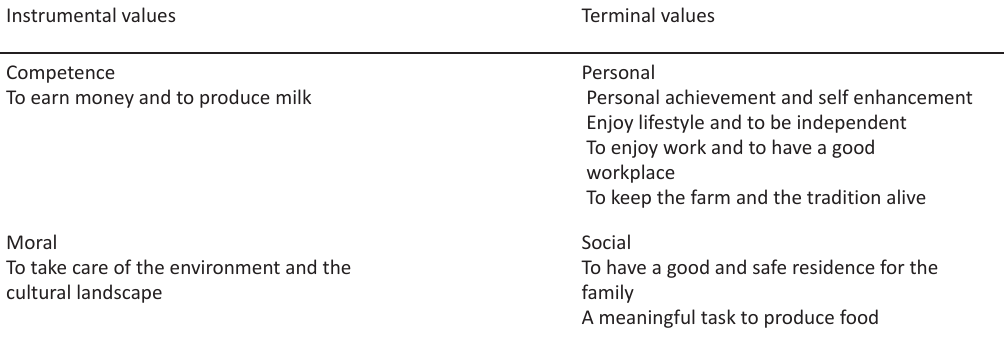
Table 4. Farmers’ values according to Rokeach’s (1973) framework